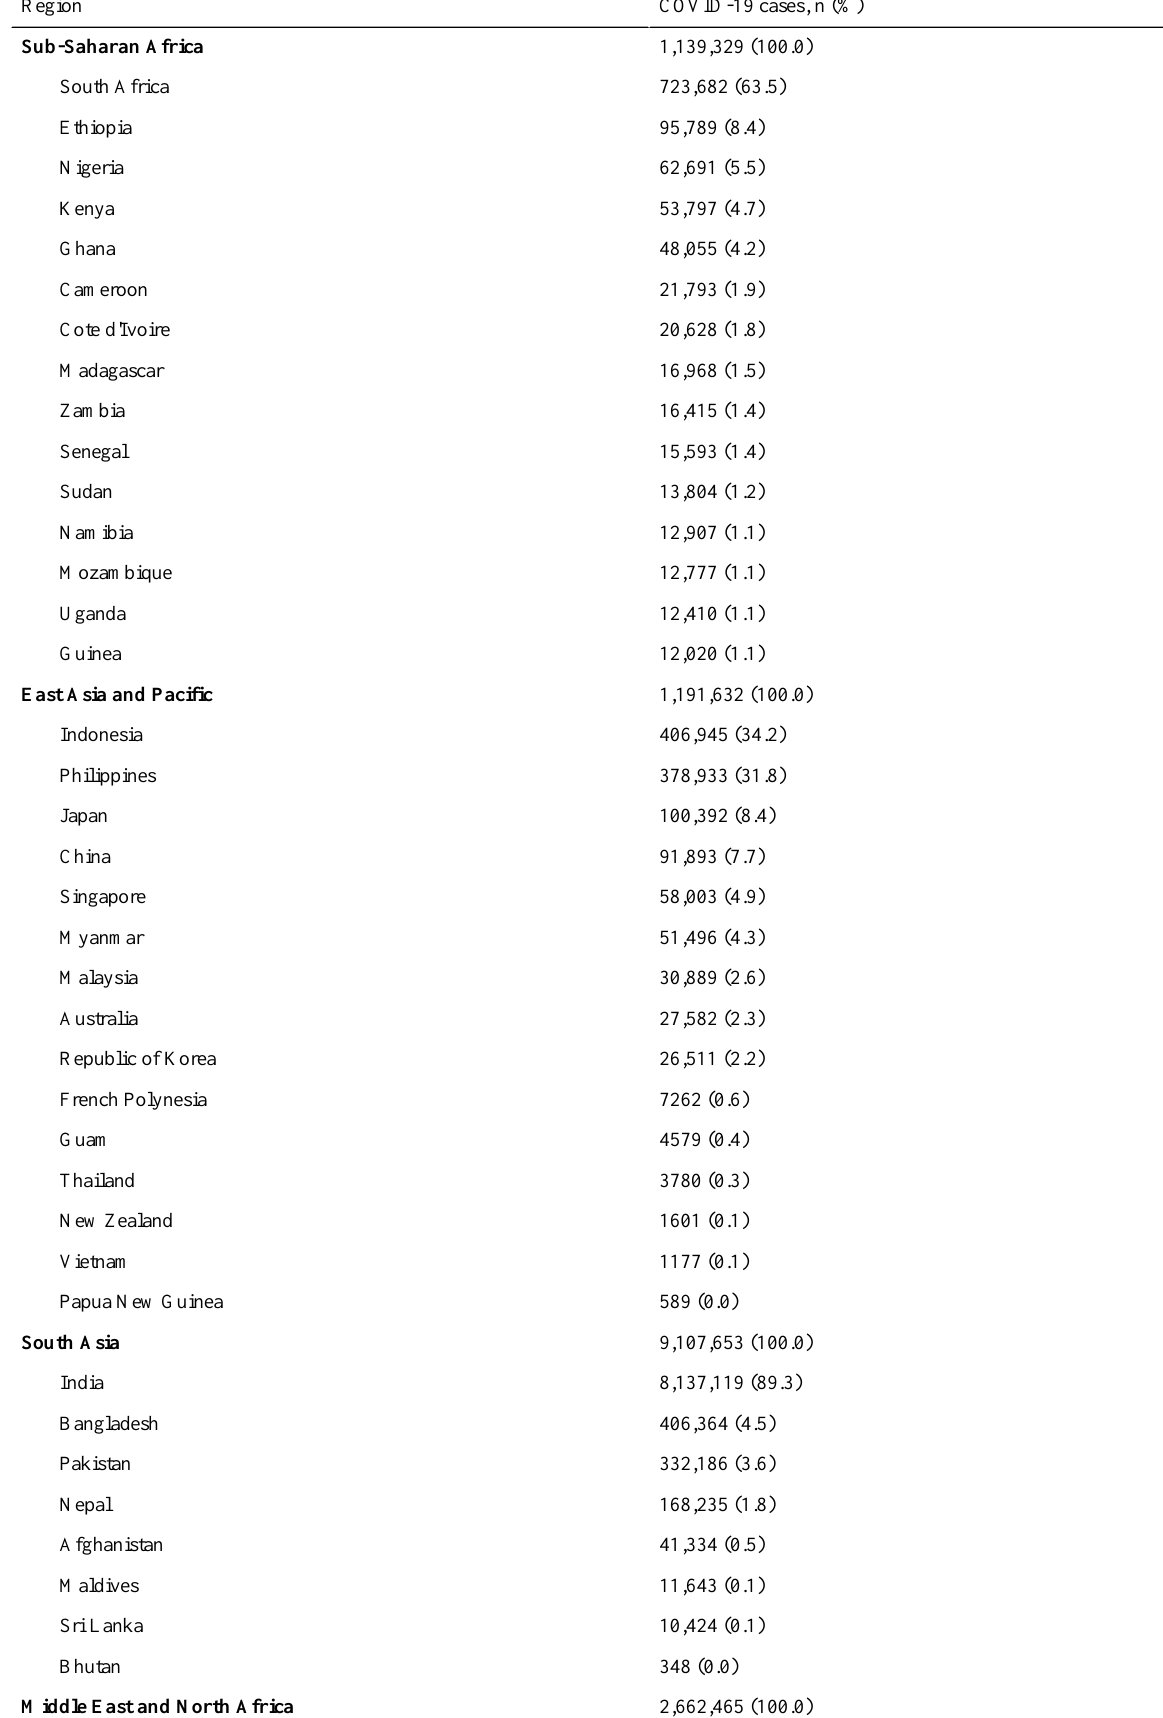
Table 2. COVID-19 cases for top 15 countries by World Bank region, from January 1 to October 31,